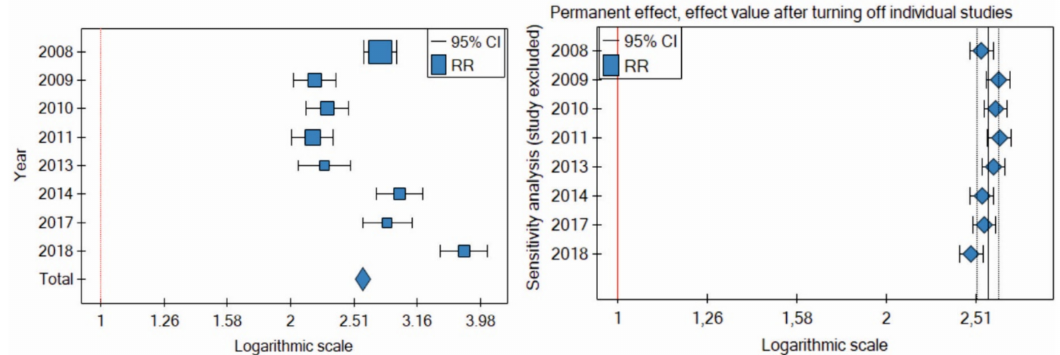
Figure 2. The relative risk of an accident at work among workers aged 18–19 years employed in Poland (own